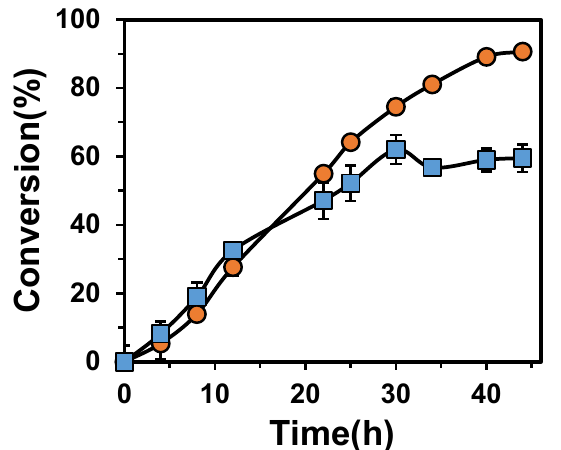
Figure 5. The synthesis of acetoin from ethanol with the immobilized cascade enzymes.